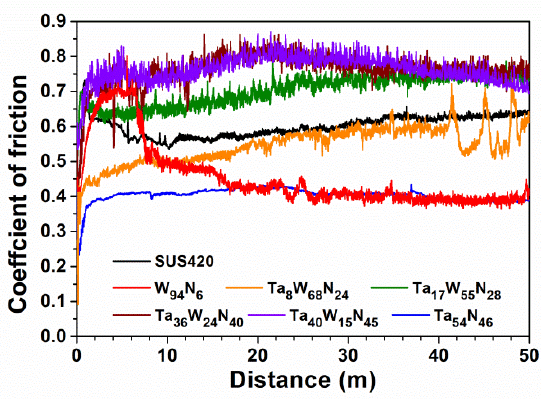
Figure 12. COFs of the TaWN/Ta/SUS420 samples.